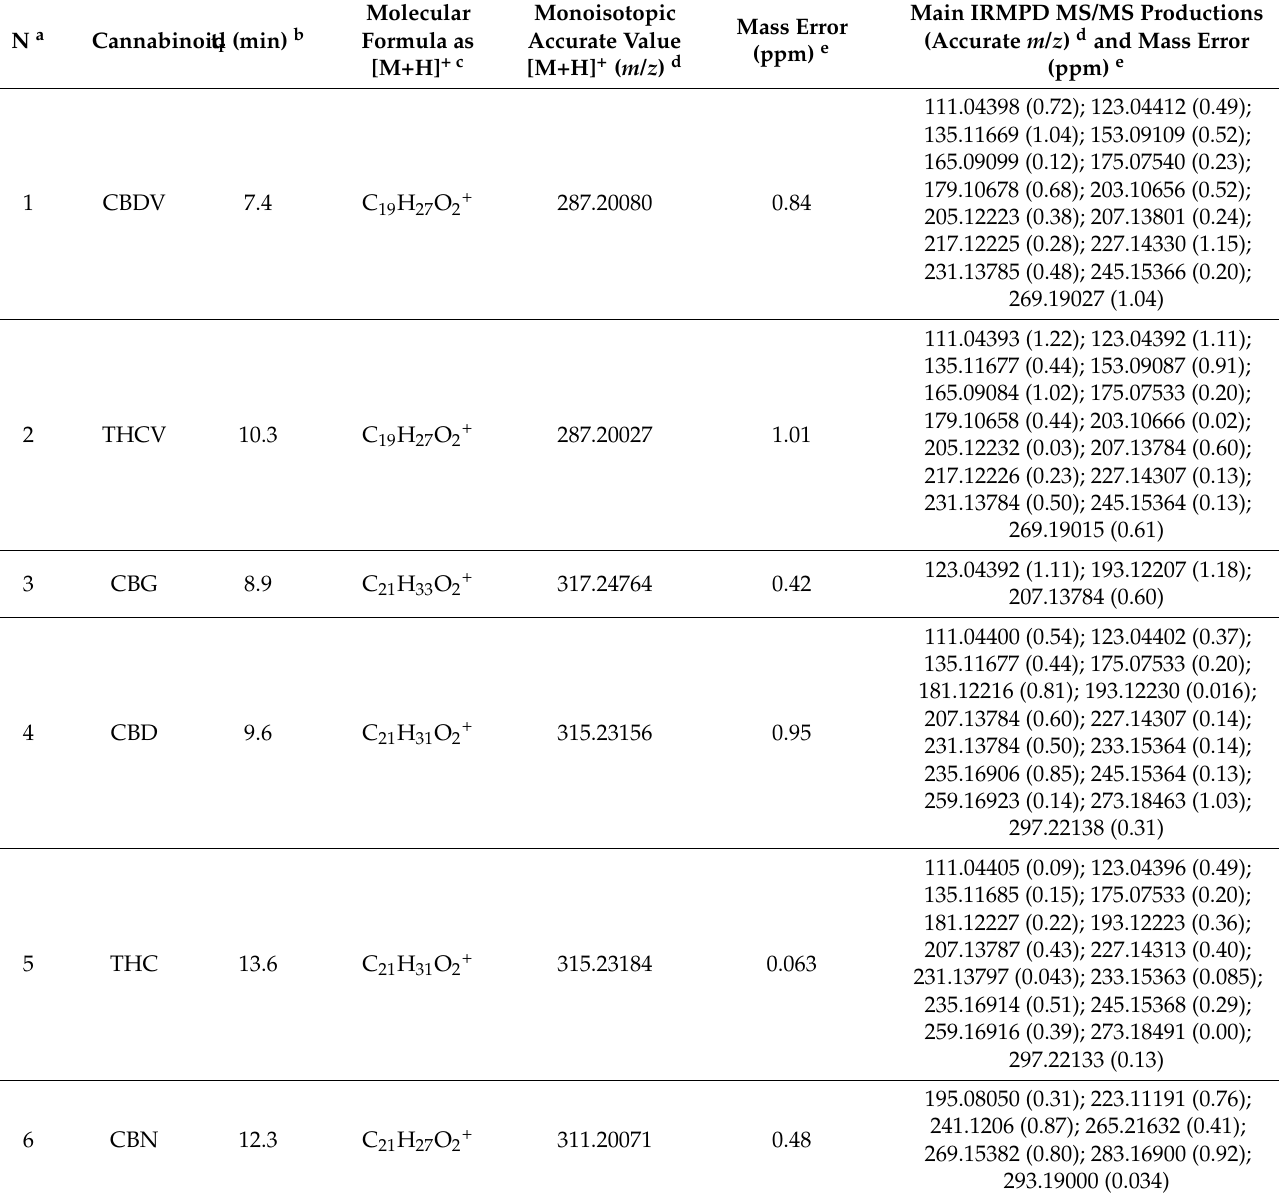
a Is the number used to identify each cannabinoid in the chromatograms of Figure 1. b Retention time of cannabinoid eluted under the experimental conditions described in the LC-MS section. c Molecular formula of protonated cannabinoid. d Average experimental value of five m / z measurements. e Mass accuracy expressed as the root mean square (RMS) in parts per million (ppm = 10 6 × [accurate mass-exact mass]/exact mass) of five m / z